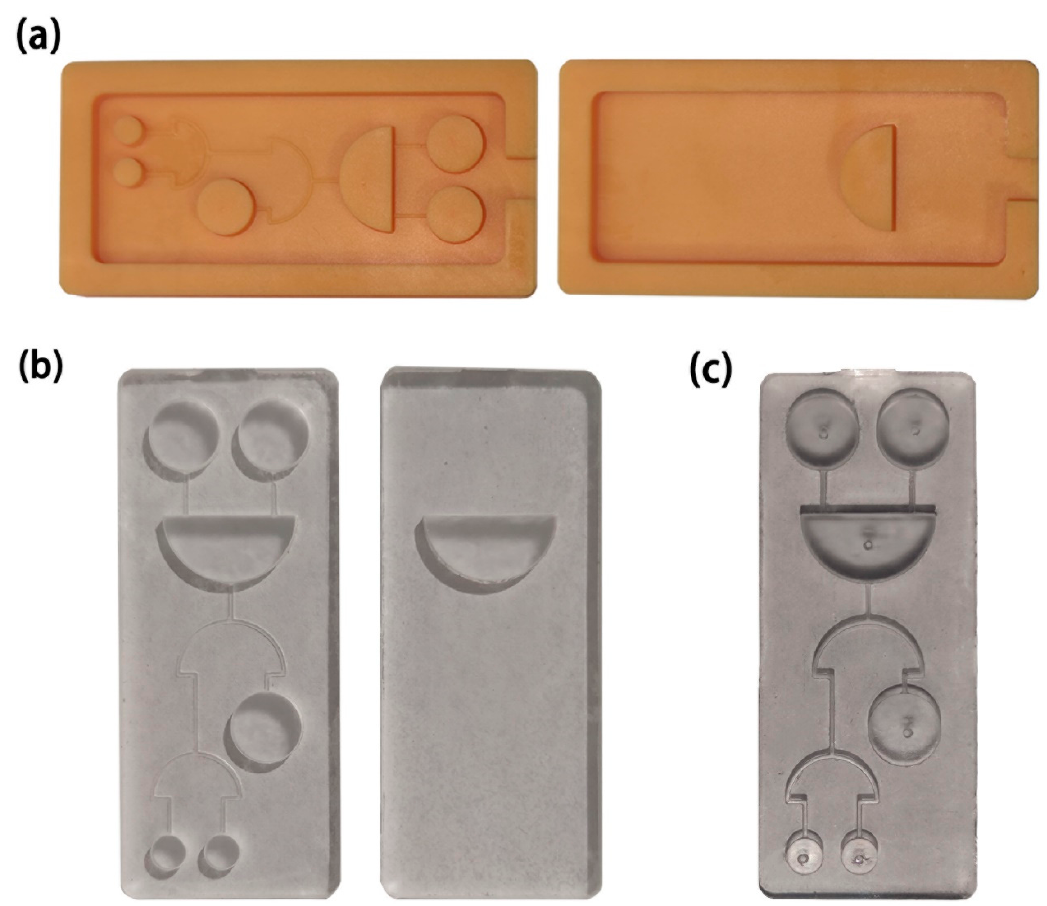
Figure 1. Photos of the manufacturing stages of the microfluidic chip: ( a ) molds of the microfluidic chip. ( b ) The function layer and readout layer of the microfluidic chip. ( c ) The assembled microfluidic chip.